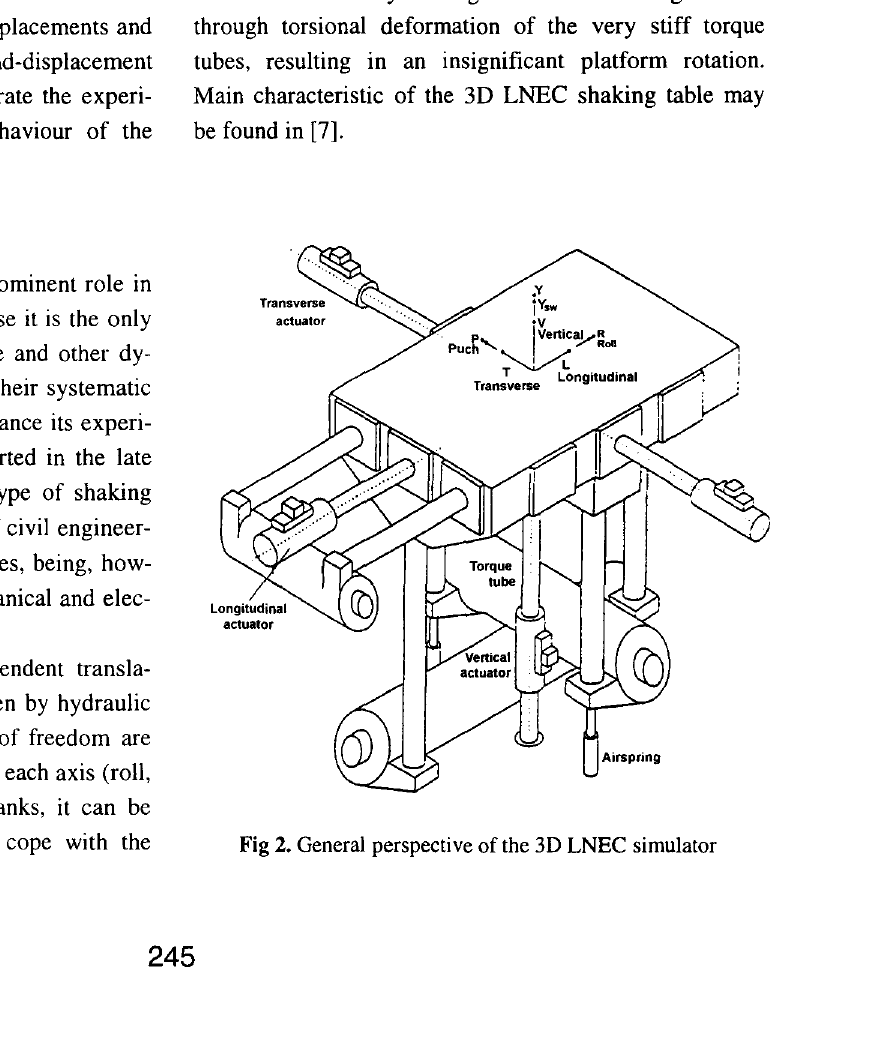
Fig 2. General perspective of the 3D LNEC